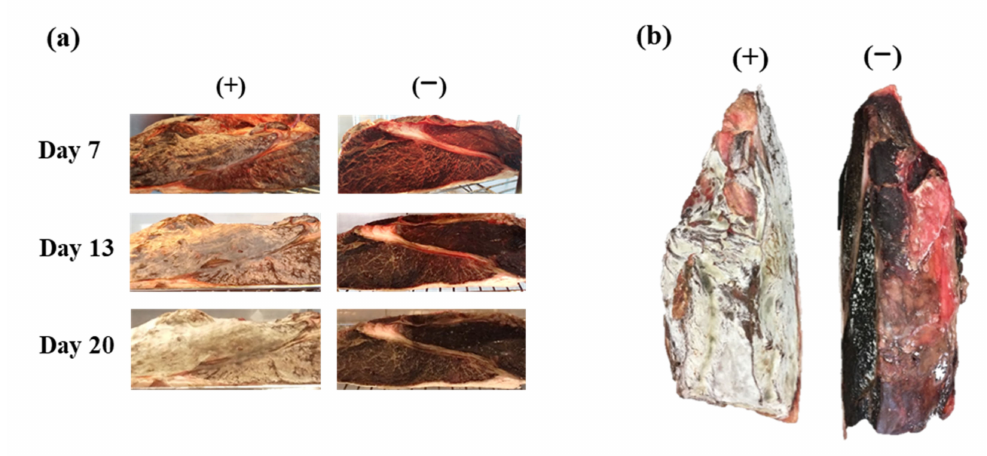
Figure 1. The appearance of dry-aged beef, with (+) and without ( − ) direct fungal-rub inoculation. ( a ) Cross-section of beef dry-aged for 7, 13, and 20 days. ( b ) Whole portion of beef dry-aged for 26